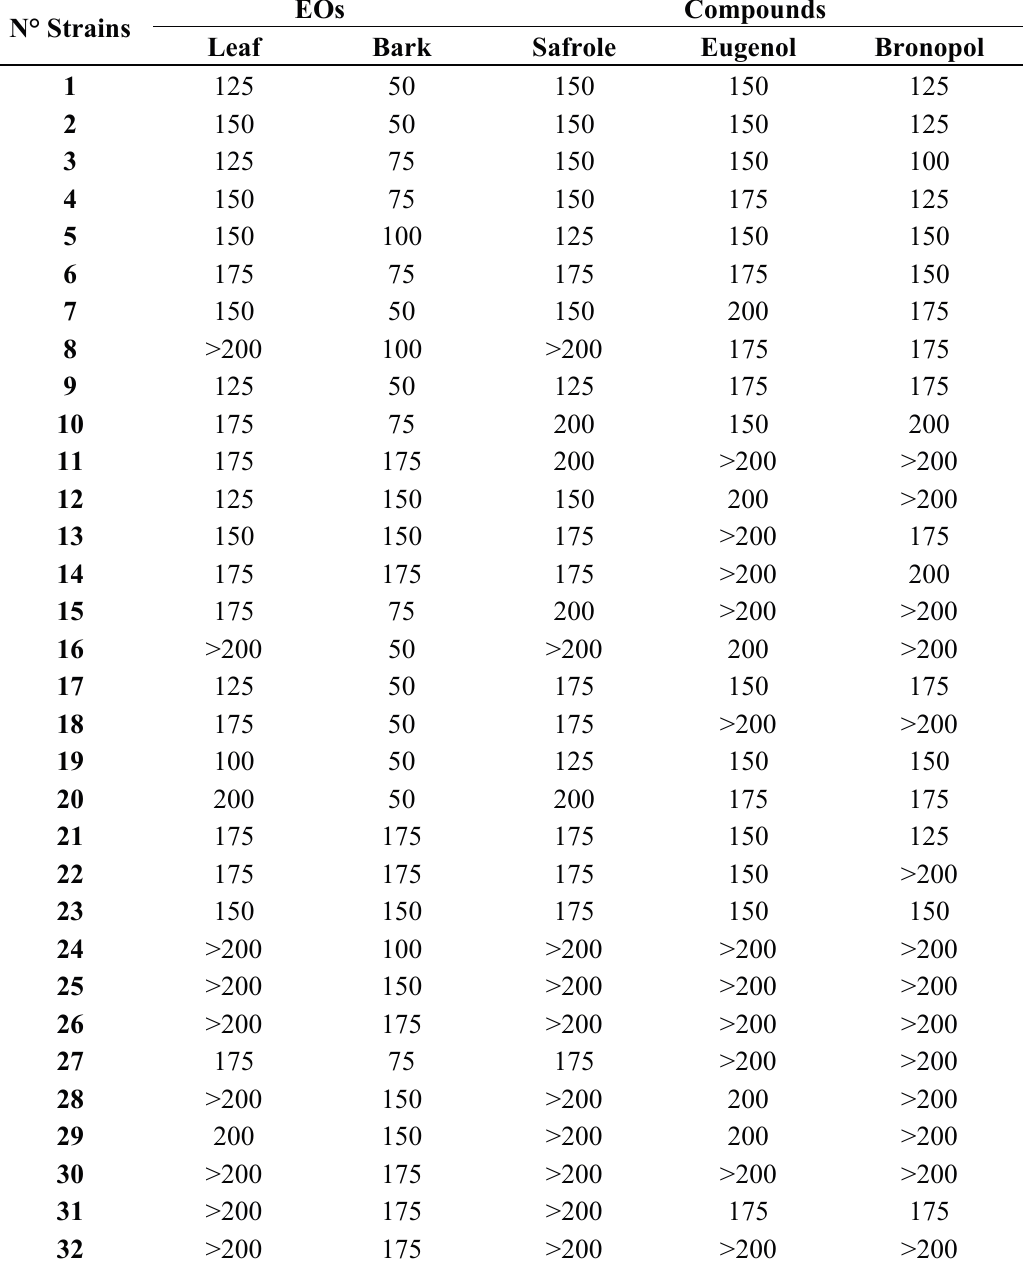
Table 3. MFC values a of leaf and bark EOs against spores at 72 h. N°